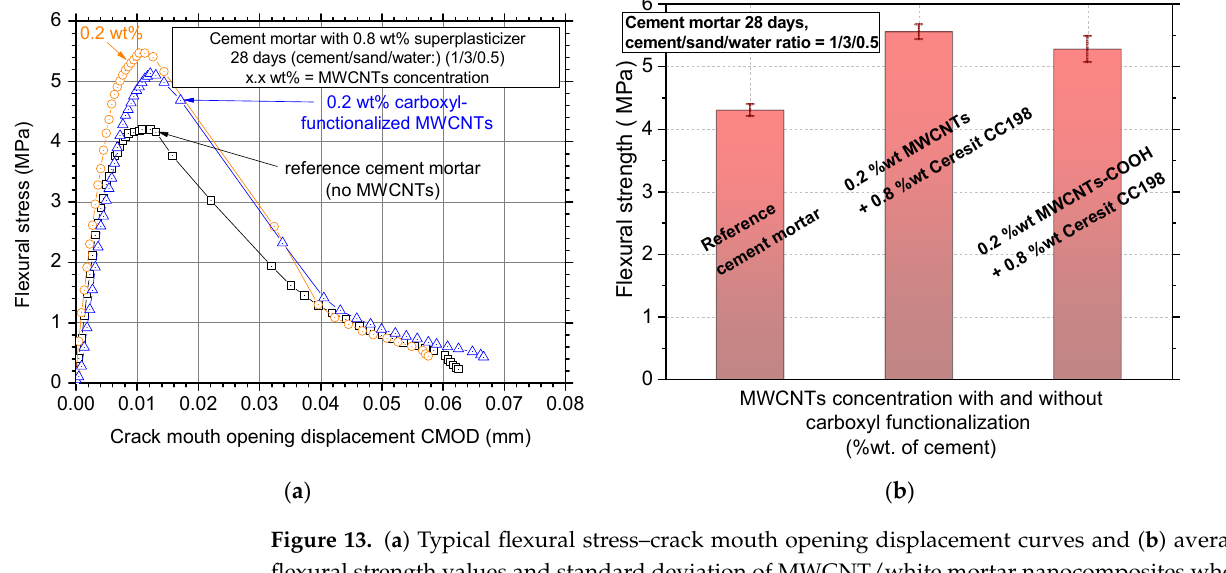
Figure 13. ( a ) Typical flexural stress–crack mouth opening displacement curves and ( b ) average flexural strength values and standard deviation of MWCNT/white mortar nanocomposites where MWCNTs were treated with and without carboxyl functionalization.